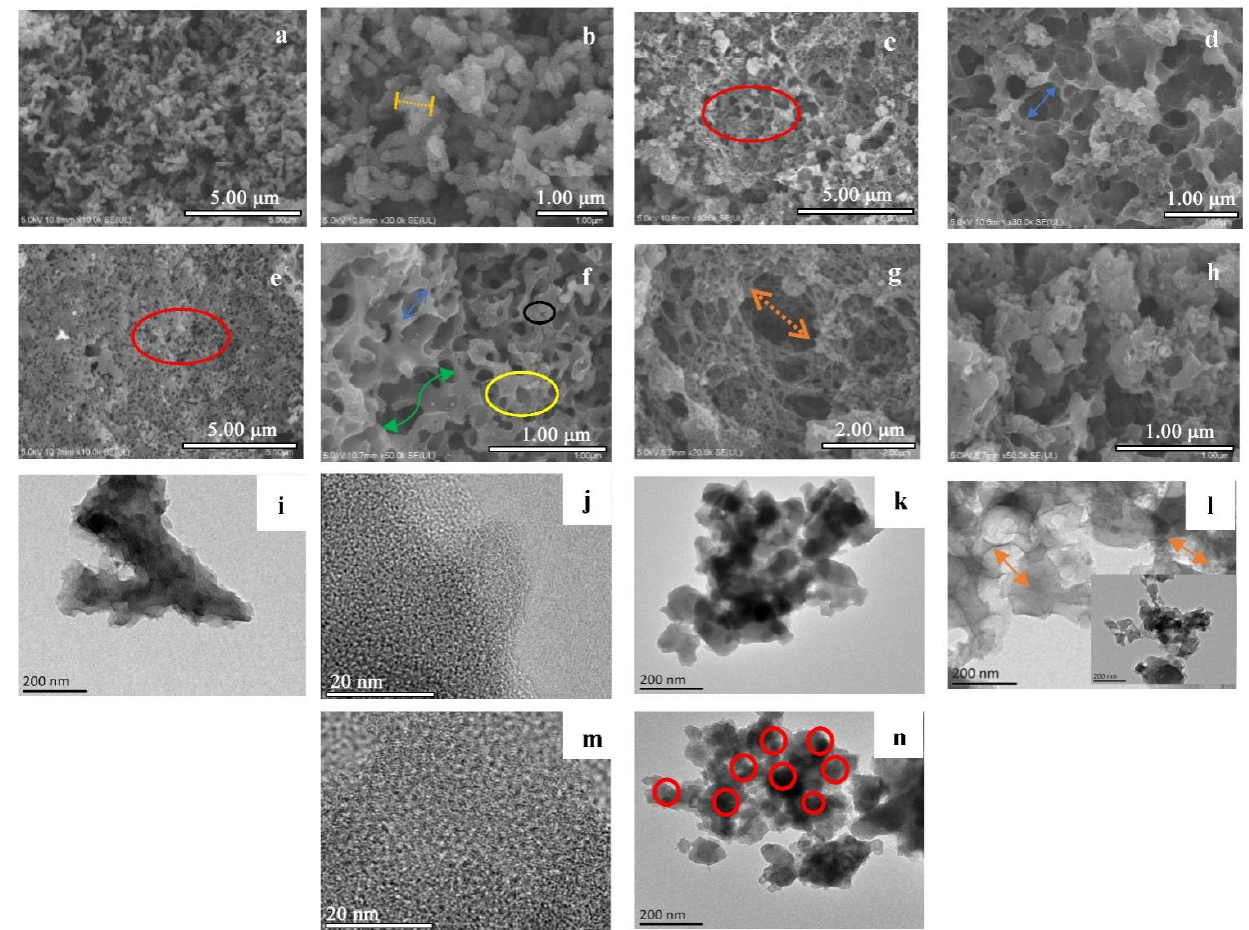
Figure 3. SEM images: ( a , b ) NC700, ( c , d ) SNC500, ( e , f ) SNC700, and ( g , h ) SNC900; TEM images: ( i , j ) NC700, ( k ) SNC500, ( l , m ) SNC700, and ( n ) SNC900.